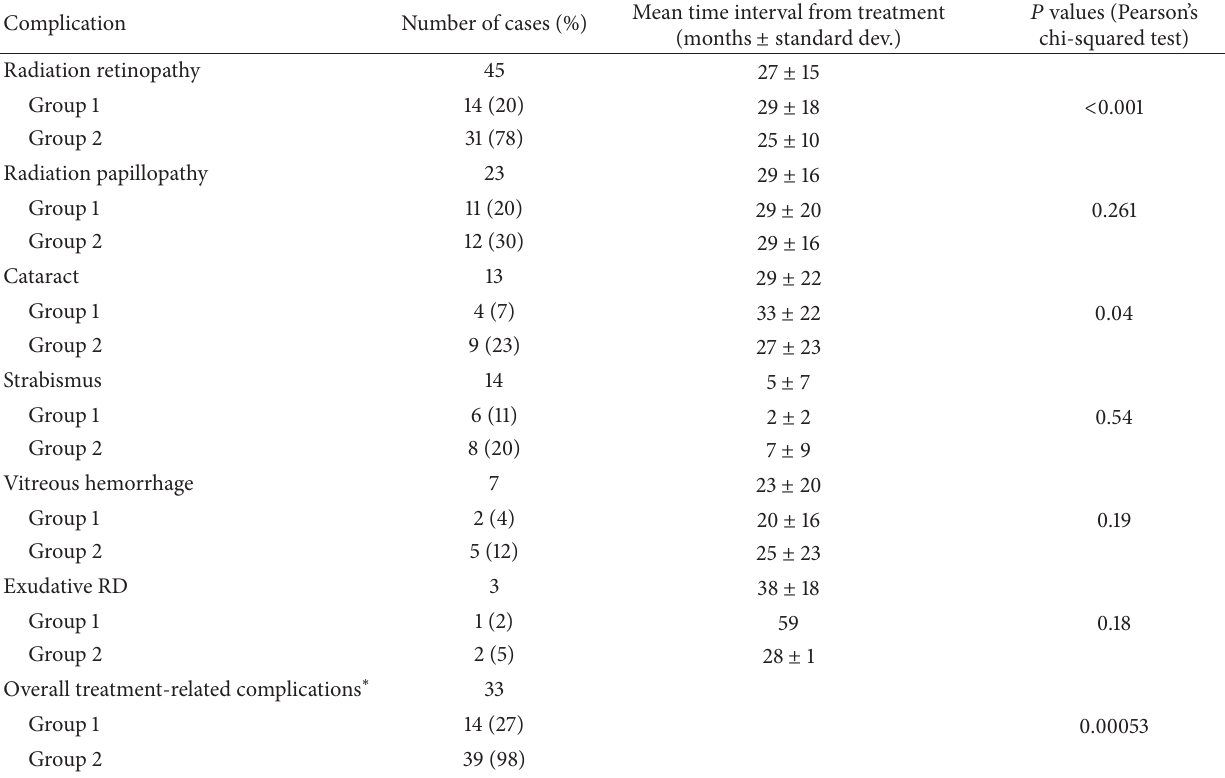
Table 4: Complications from iodine-125 plaque irradiation at 10